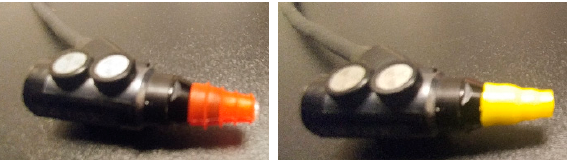
Figure 1. The red eartip (3–5 mm Flanged Sanibel Red Silicone) used initially in this study is shown on the left and the yellow eartip (3 mm Flanged Sanibel Yellow Silicone) used for the remainder of the study is shown on the right.